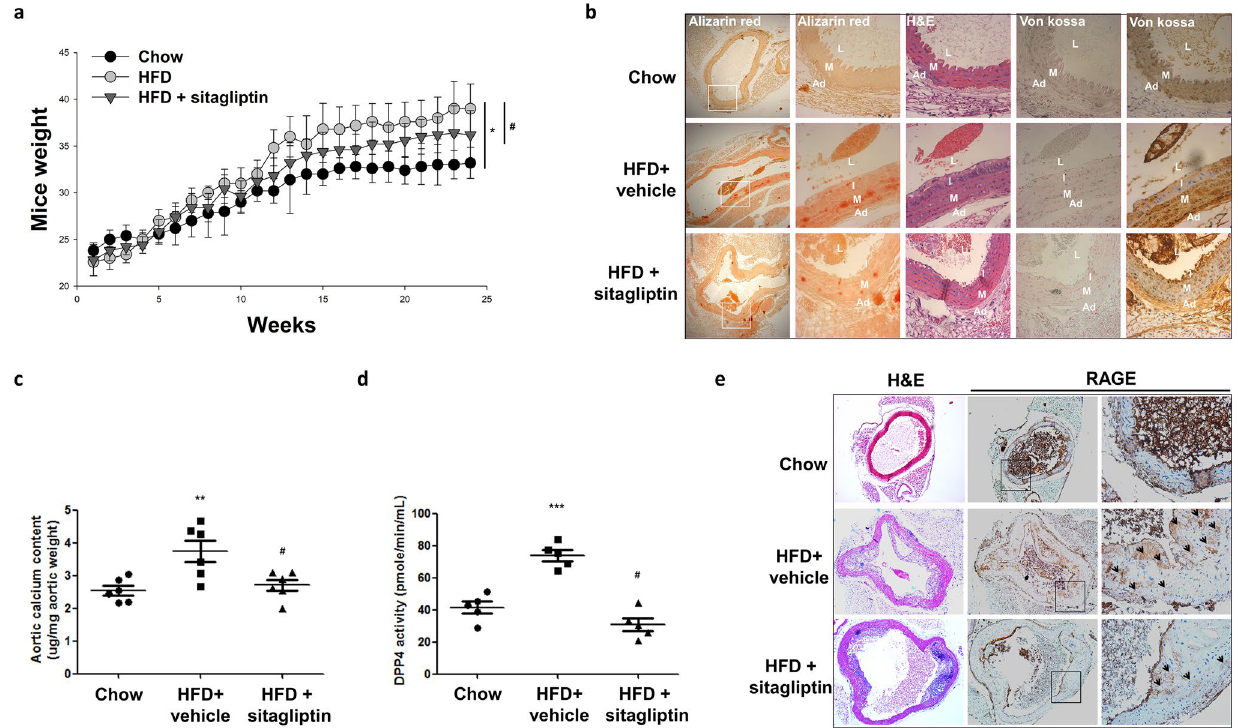
Figure 1. HFD promoted calcification, which was attenuated by sitagliptin, in male LDLR −/− mice. LDLR −/− mice were fed with a chow diet or HFD and simultaneously treated with sitagliptin (Sita, 100 mg/kg/day) for 6 months. (a) LDLR −/− mouse body weight was recorded weekly. (b) HFD-induced artery atherosclerotic plaque formation was detected by H&E staining. HFD-induced artery calcification was detected by alizarin red staining. HFD promoted aortic calcification, which was dominant in the medial layer. The arrows point to the area of calcium deposition. The lumen showed blood cell remnants. L lumen, I intima, M media, and A adventitia. (ND = 6, HFD = 6, and sitagliptin = 6). LDLR −/− mice aorta were photographed at × 100 and × 400 magnifications. (c) Aortic calcium levels and (d) DPP4 activity were assayed. (e) Immunostaining of aortic RAGE showed that sitagliptin could significantly decrease the stimulatory effects of HFD on RAGE. Arrowhead indicates positive RAGE position. * P < 0.05 compared with the chow group, and # P < 0.05 compared with the HFD groups (Aortic calcium levels; Chow = 6, HFD + vehicle = 6, and HFD + sitagliptin = 6. DPP4 activity was assayed; Chow = 5, HFD + vehicle = 5, and HFD + sitagliptin =